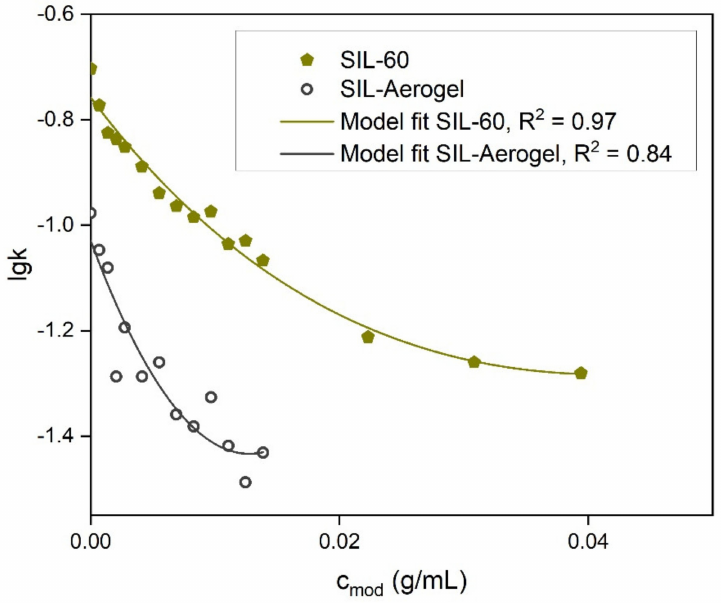
Figure 5. Retention factors of toluene on SIL-60 and SIL-Aerogel and model fittings according to DIM-Lan-kcK’. SFC conditions: 200 bar, 40 ◦ C, injection volume 2 µ L, flow rate 2 mL min − 1